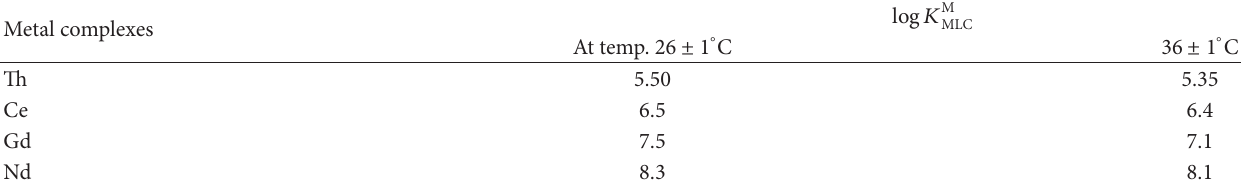
T 1: Stability constants of ternary complexes of Lanso (L) and Cyto (C) at 26